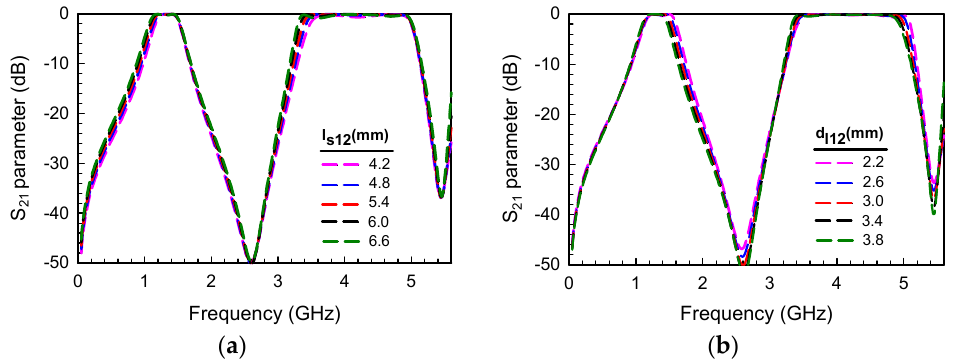
Figure 17. Bandwidth control of both passbands according to changes in ( a ) l s12 = l s21 , ( b ) d l12 = d l21 .